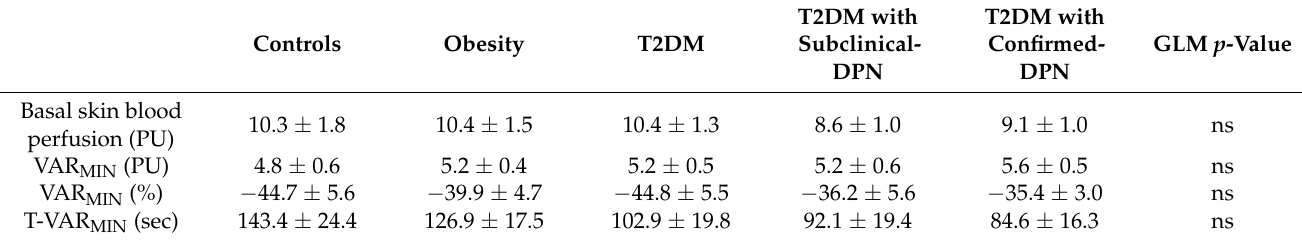
adjustment for basal skin temperature and/or age, this blunted decrease remained across both skin sites. Table 2. Microcirculation variables at rest and during the venoarteriolar reflex in each group. Controls Obesity